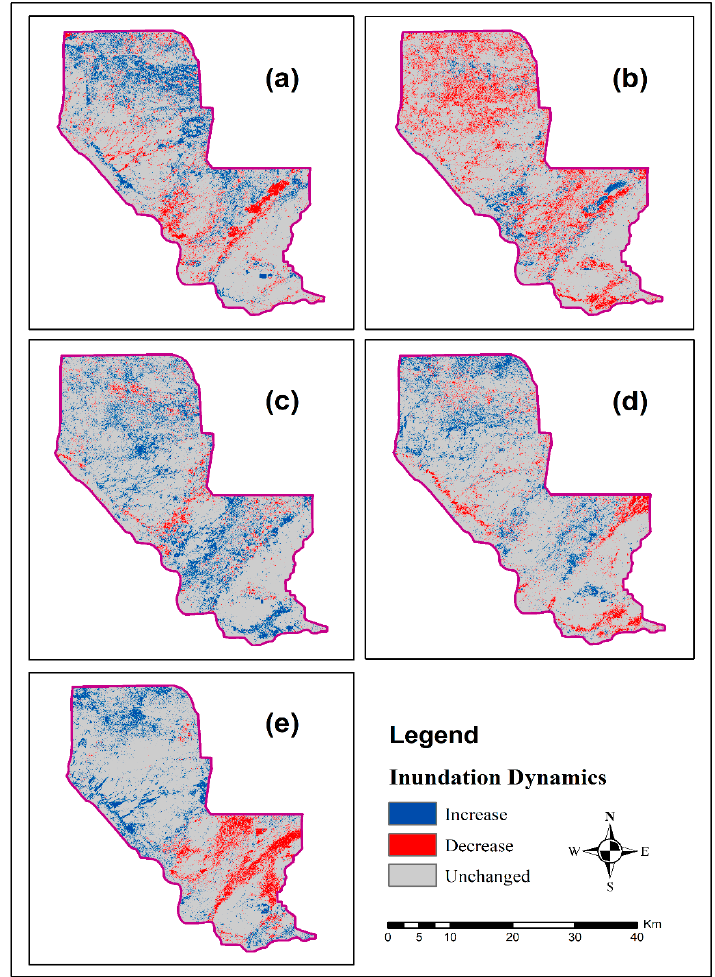
Figure 8. The spatial distribution of inundation dynamics in dry season: ( a ) 2002–2006, ( b ) 2006–2010, ( c ) 2010–2014, ( d ) 2014–2018, and ( e ) 2018–2021.